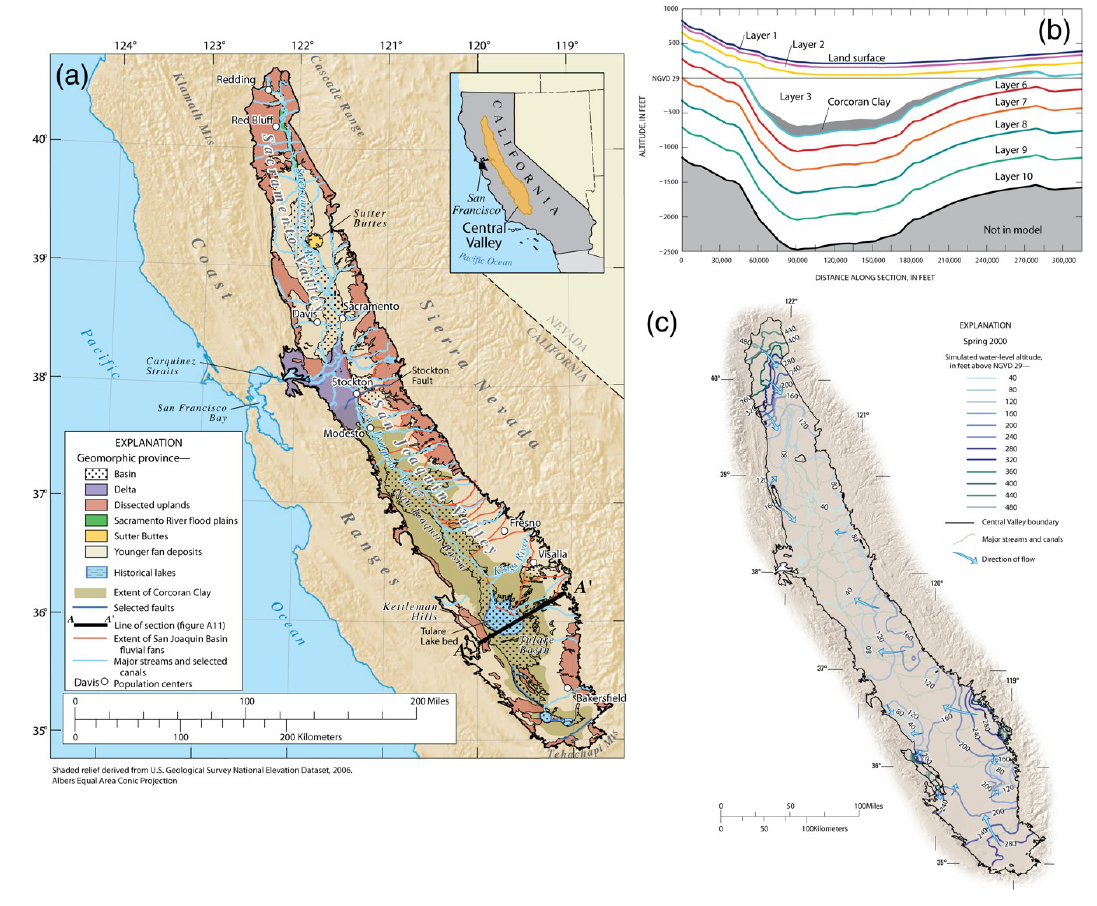
Figure 2. ( a ) Geomorphic map of surficial units in the Central Valley. Note the extent of Corcoran Clay, a major confining unit. ( b ) Generalized hydrogeologic cross-section (A-A’ in ( a )) indicating layers used in the United States Geological Survey (USGS) groundwater model of the San Joaquin Valley and the location of the Corcoran Clay. Figures from [1]. ( c ) The altitude of the unconfined part of the aquifer system and groundwater flow paths simulated for Spring 2000 by [1].